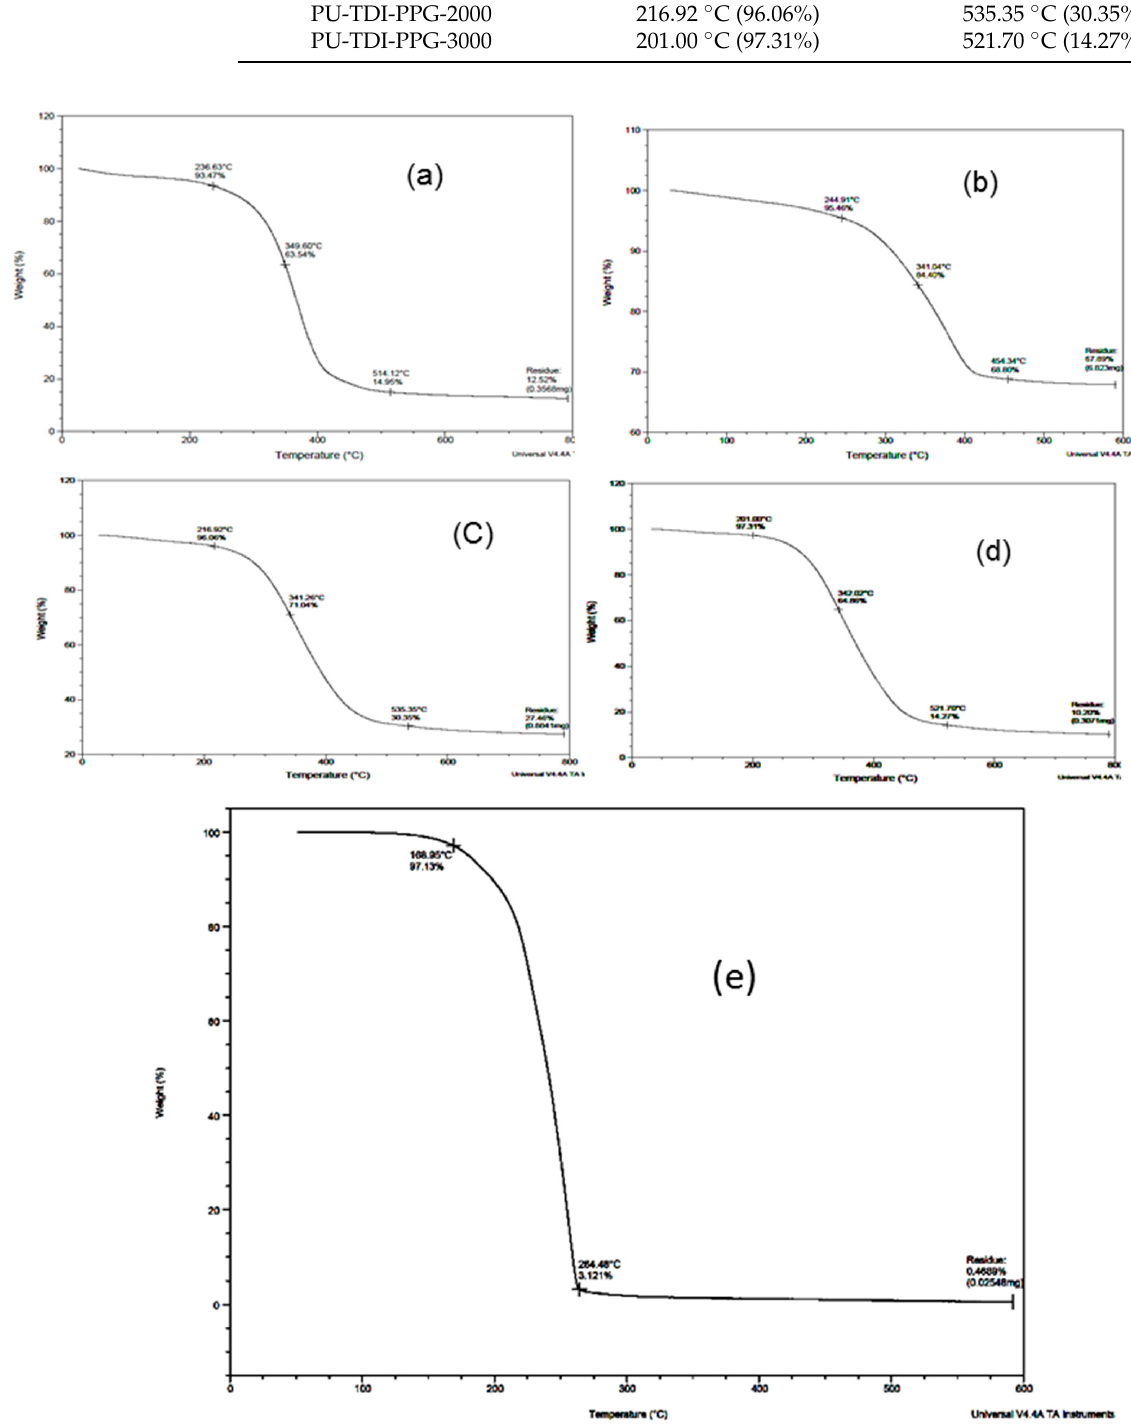
Figure 5. TGA thermogram of ( a ) TDI-PEG-400, ( b ) TDI-PPG-1000, ( c ) TDI-PPG-2000 and ( d ) TDI-PPG-3000; ( e ) blocked